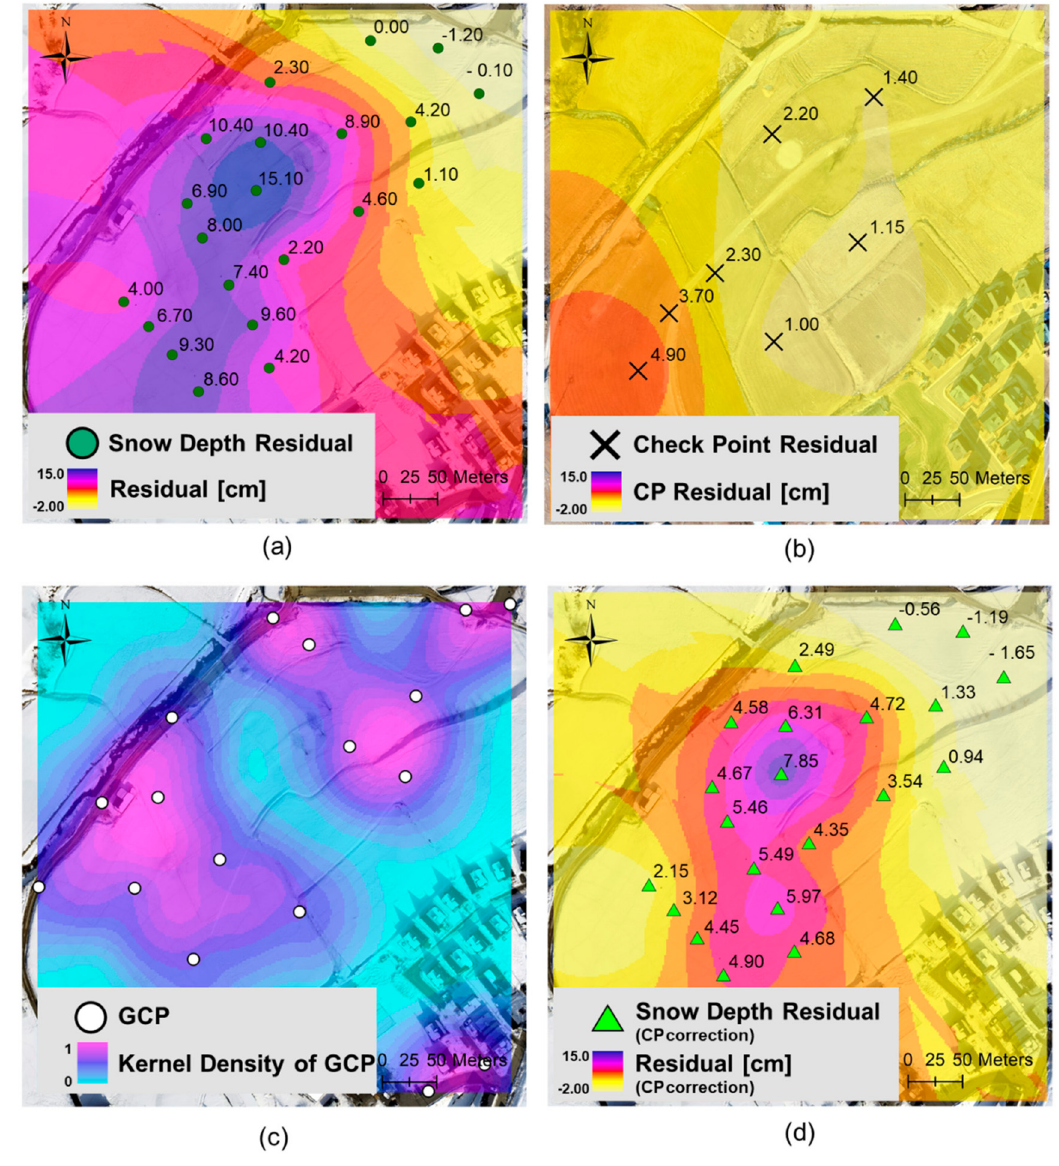
Figure 11. ( a ) Map of the error between the estimated snow depth DSM and the measurement. ( b ) Map of the check point error. ( c ) Kernel density of spatially distributed GCP points. ( d ) Map of the error snow depth after CP